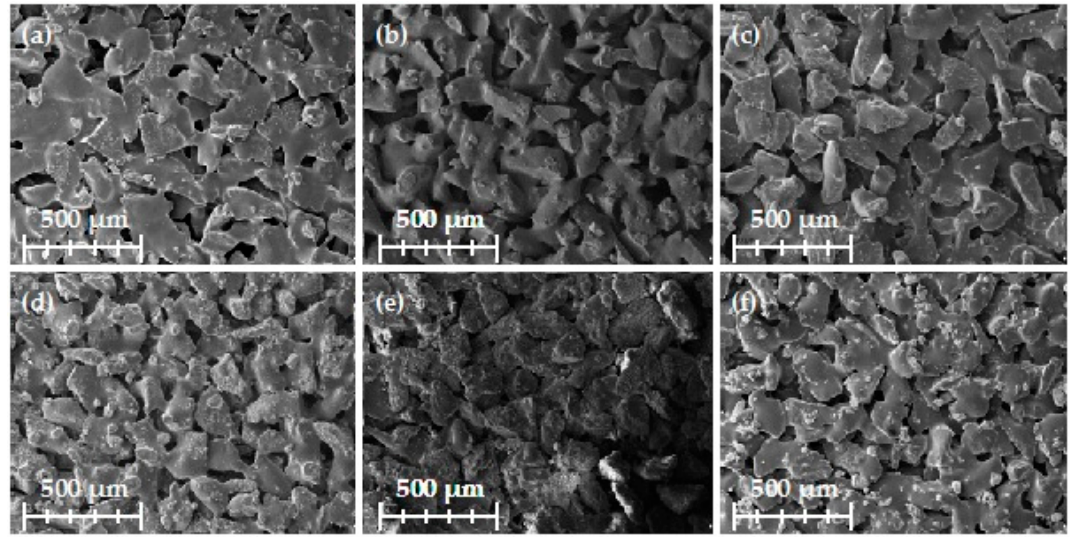
Figure 10. Scanning electron microscopy images of examined composites: ( a ) MLS; ( b ) MLS activated using NaIO 4 ; ( c ) MLS activated using H 2 O 2 ; ( d ) KL; ( e ) KL activated using NaIO 4 ; and ( f ) KL activated using H 2 O 2 .